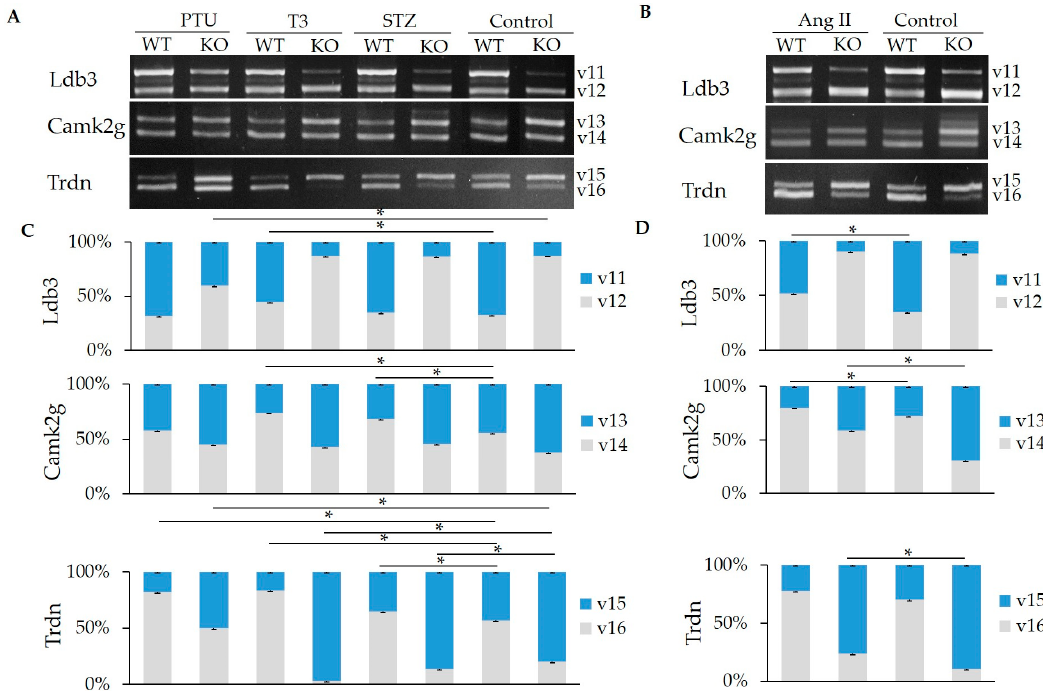
Figure 3. Splicing pattern of Ldb3 , Camk2g , and Trdn genes in WT and KO rats treated with PTU, T3, STZ, and Ang II. ( A ) RT-PCR results of Ldb3 , Camk2g , and Trdn splicing under PTU, T3, and STZ treatment in heart tissues; ( B ) RT-PCR results of Ldb3 , Camk2g , and Trdn splicing under Ang II treatment in heart tissues. ( C ) Quantification of band density of different splicing variants of Ldb3 , Camk2g , and Trdn under PTU, T3, and STZ treatment; ( D ) Quantification of band density of different splicing variants of Ldb3 , Camk2g , and Trdn under Ang II treatment. v, variants; 11–16, different variants. Mean ± SE ( n = 3), * p < 0.05.